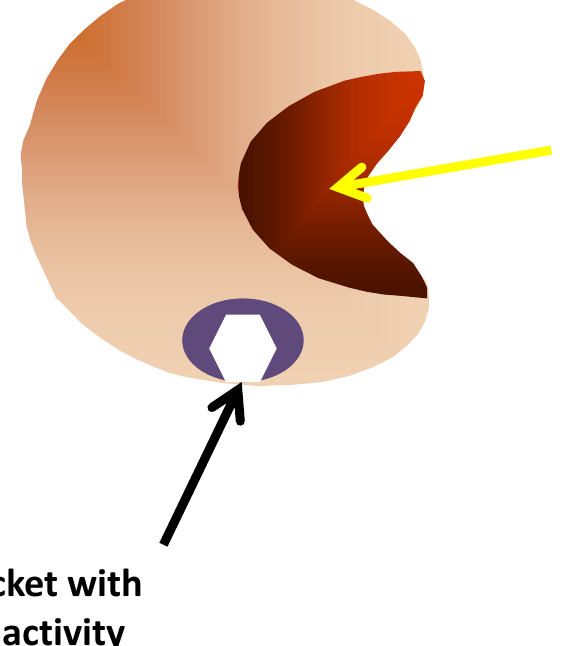
Figure 1. Enzymes having promiscuous activities not related to the main active